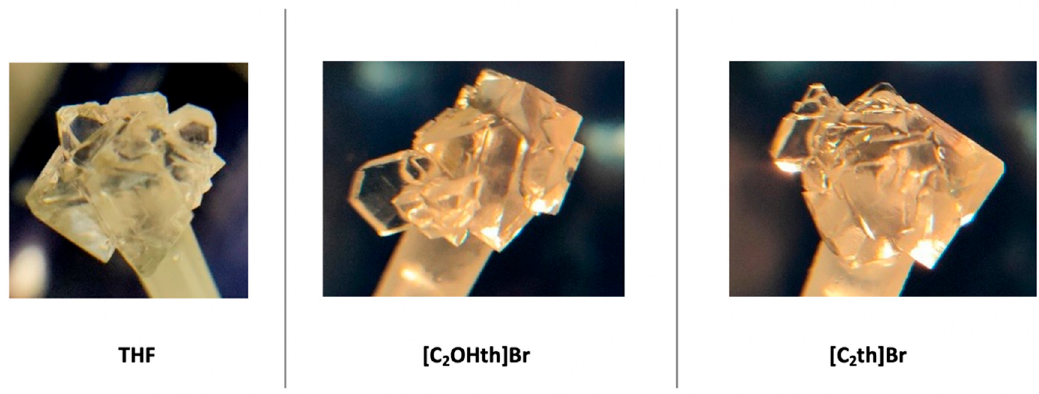
Figure 8. Morphology of THF hydrates in the absence and presence of ILs.